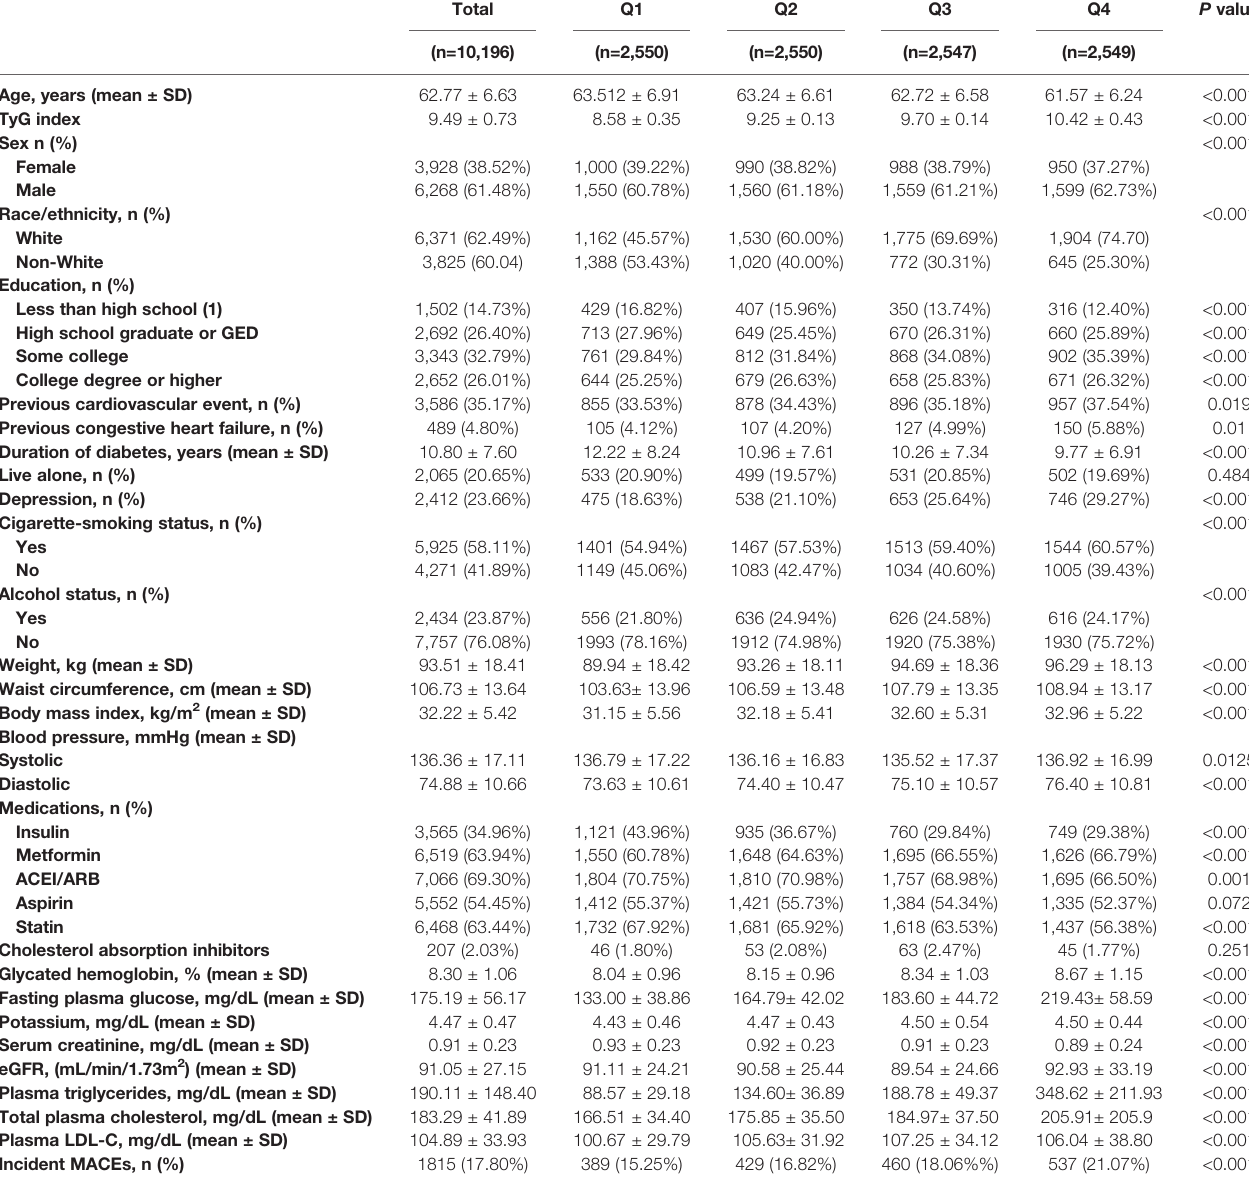
TABLE 1 | Baseline characteristics of participants by quartiles of TyG